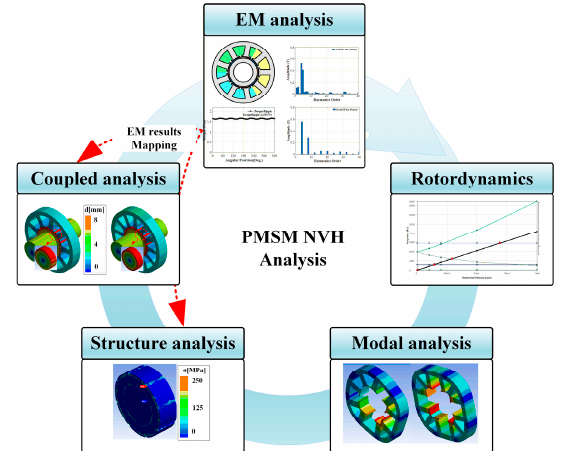
Figure 6. Thenoise, vibration, andharshness(NVH)analysisprocessofthepermanentmagnetsynchronous Figure 6. The noise, vibration, and harshness (NVH) analysis process of the permanent magnet motor (PMSM). synchronous motor (PMSM).